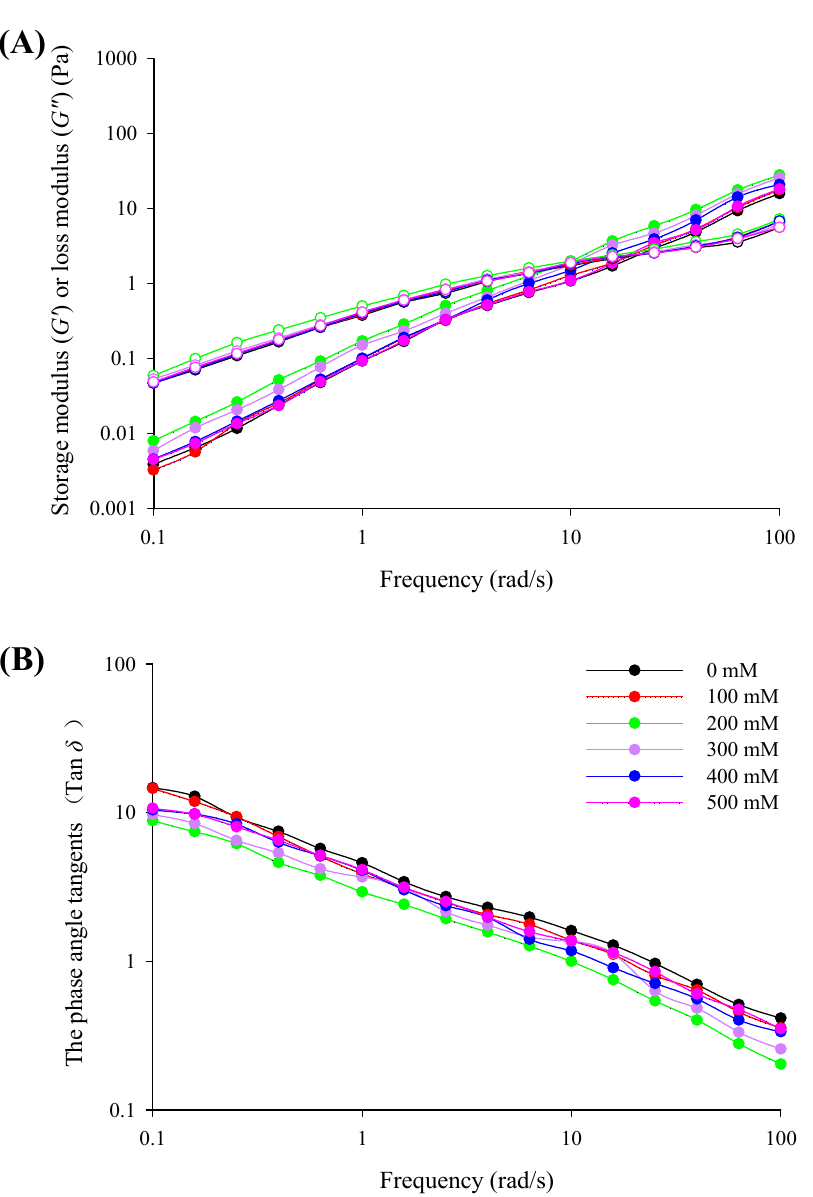
Figure 5. Frequency dependency of storage modulus ( G ′ ) or loss modulus ( G ″ ) ( A ), and the phase angle tangents (Tan δ ) ( B ) for filled hydrogels at different NaCl concentrations. Table 3. Parameters of power law model in frequency sweep tests for filled hydrogels with different NaCl concentrations.